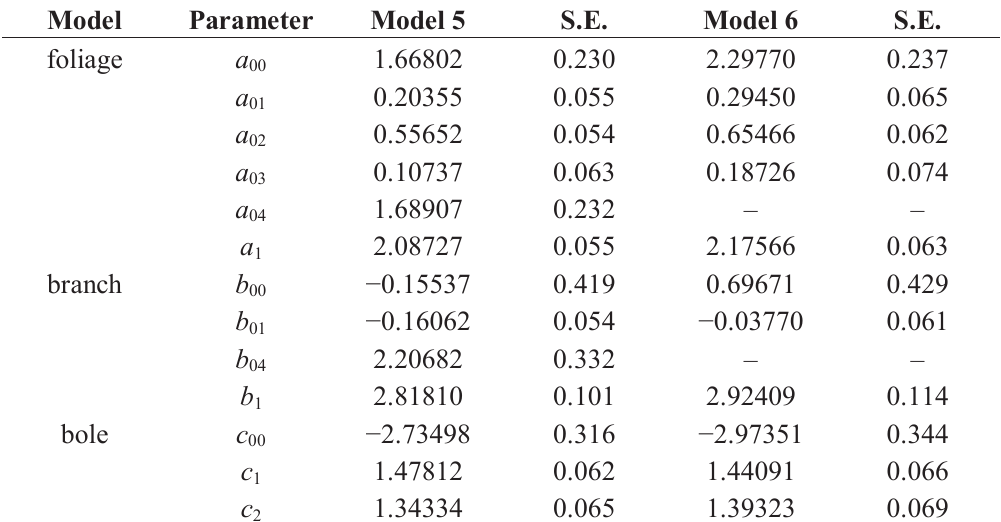
Table 4. Parameter estimates for tree foliage biomass, branch biomass, and bole biomass from selected models based on models 5 and 6.